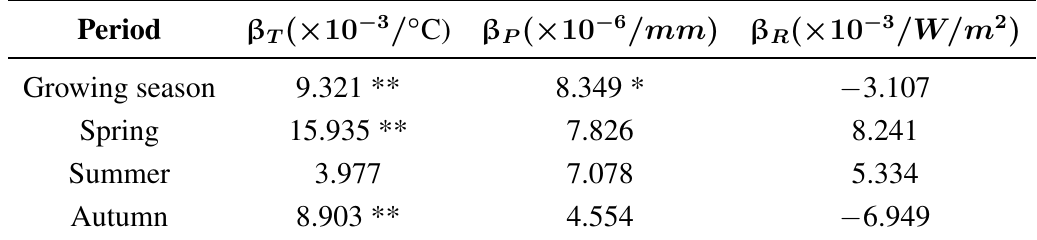
Table 1. Regression coefficients between NDVI and temperature ( β precipitation ( β ) and NDVI and radiation ( β P and autumn from 1982 to 2010. (** p < 0 . 01 ; * p < 0 . 05